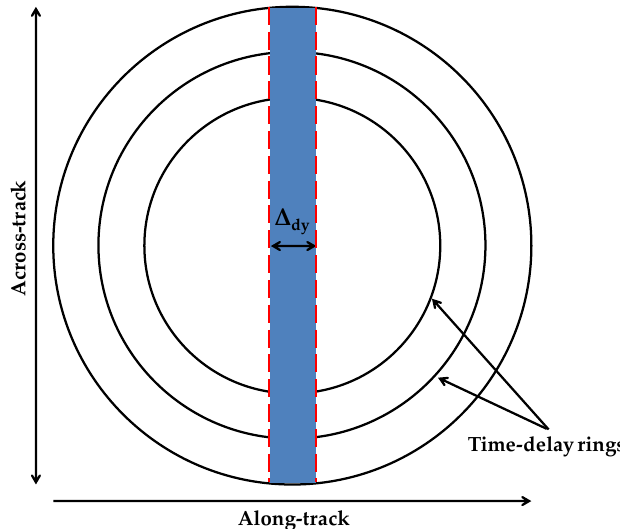
Figure 2. Doppler resolution strip along-track (from ESA CryoSat-2 Product Handbook - Baseline D 1.0 - C2-LI-ACS-ESL-5319).